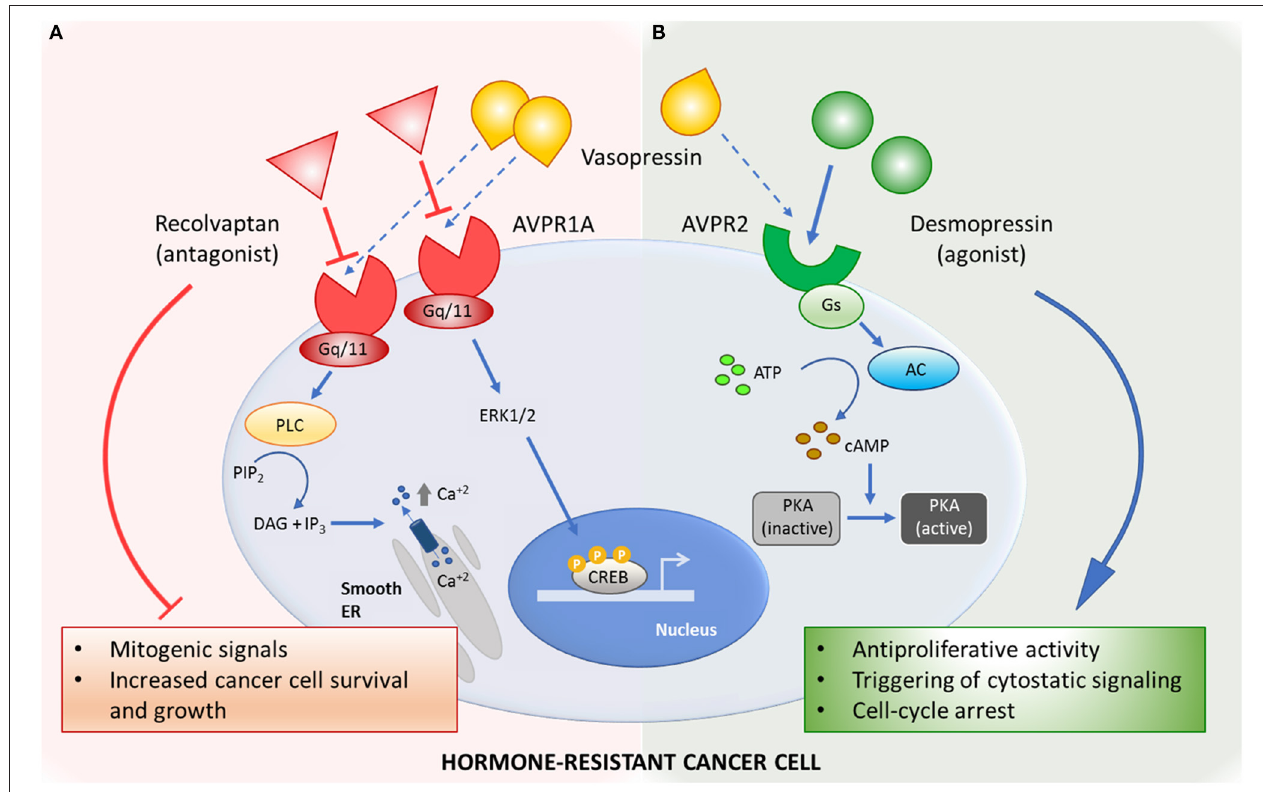
FIGURE 1 | Mechanisms of action of the vasopressin system-related drugs in hormone-resistant cancer. (A) Selective AVPR1a-antagonist relcovaptan blocks mitogenic signals triggered by natural ligand vasopressin. (B) Activation of AVPR2 by selective agonist desmopressin inhibits cancer cell growth by activating antiproliferative signaling pathways. AC, adenylyl cyclase; ATP, adenosine triphosphate; AVPR1a, arginine vasopressin receptor type 1A; AVPR2, arginine vasopressin receptor type 2; cAMP, cyclic adenosine monophosphate; CREB, cAMP-response-element-binding protein; DAG, diacylglycerol; ER, endoplasmic reticulum; ERK1/2, extracellular signal–regulated kinases; Gq/11, Gq protein alpha subunit; Gs, Gs protein alpha subunit; IP3, inositol-1,4,5-trisphosphate; PIP2, phosphatidyl inositol-bisphosphate; PKA, cAMP-dependent protein kinase; PLC, phospholipase